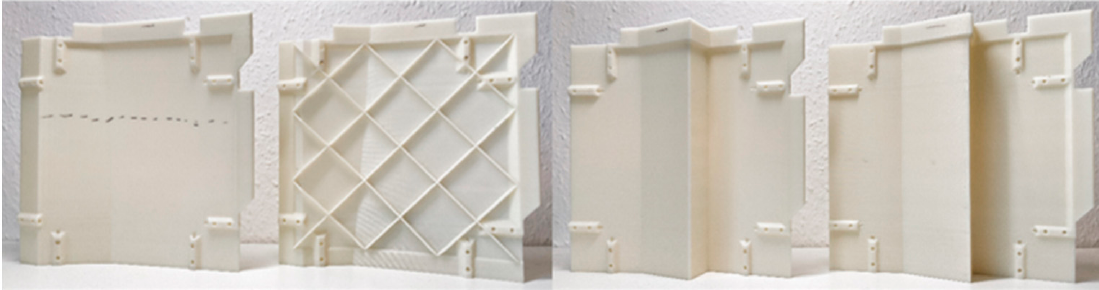
Figure 18. The four segments of the example after additive manufacturing in ABS.